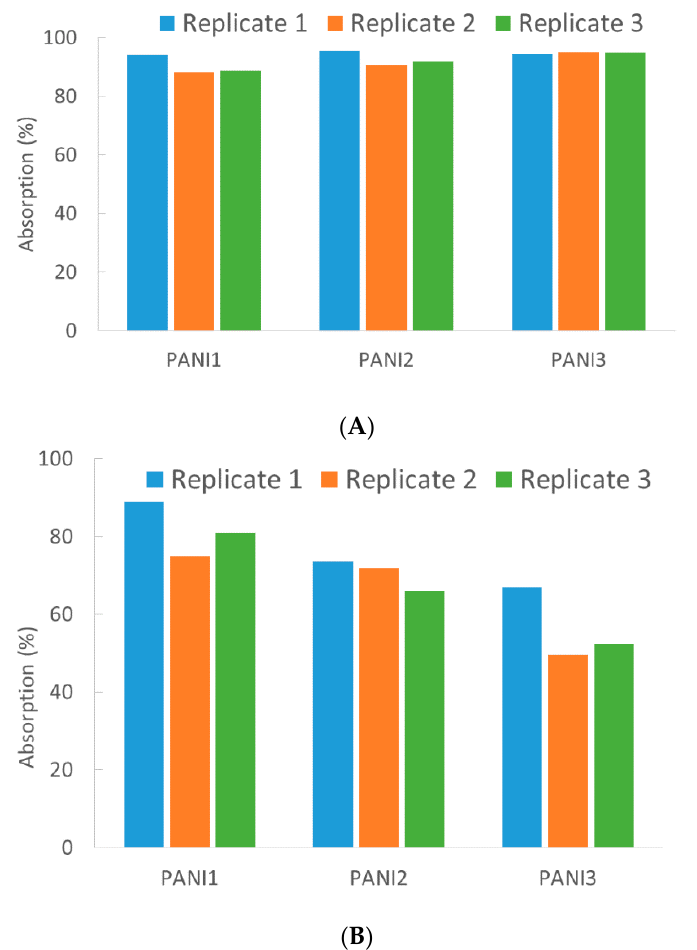
Figure 7. Percentage of sorption e ffi ciency (three replicates for each material) toward n -dodecane (C12) ( A ) and MO ( B ) for PANI1, PANI2 and